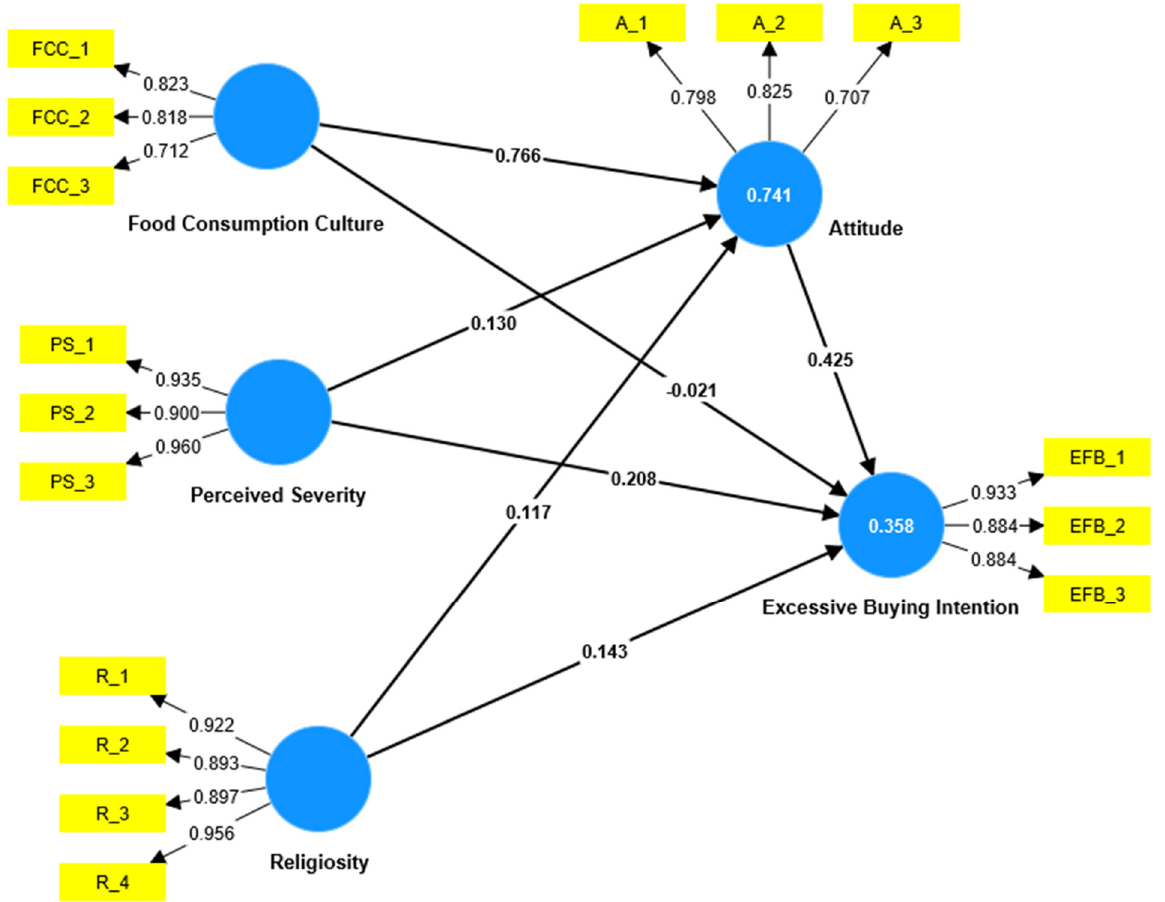
Figure 2. The research inner